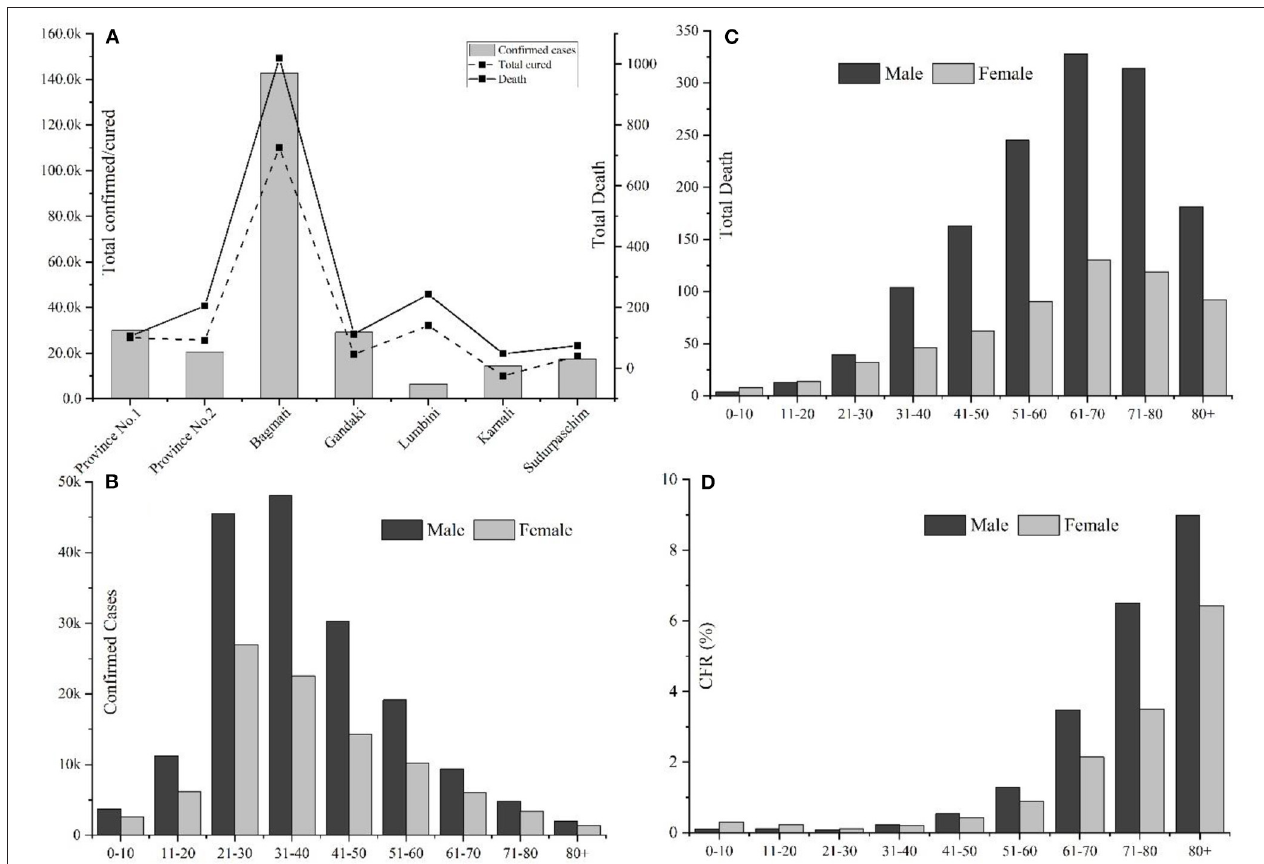
FIGURE 1 | Overview of COVID-19 cases in Nepal up to January 22, 2021. (A) Province-wise distribution of total confirmed cases, recovery, and deaths; (B) Gender, age-wise distribution of COVID-19 confirmed cases; (C) Gender-age wise distribution of COVID-19 death cases; and (D) Age and gender-wise case fatality rate (CFR) in